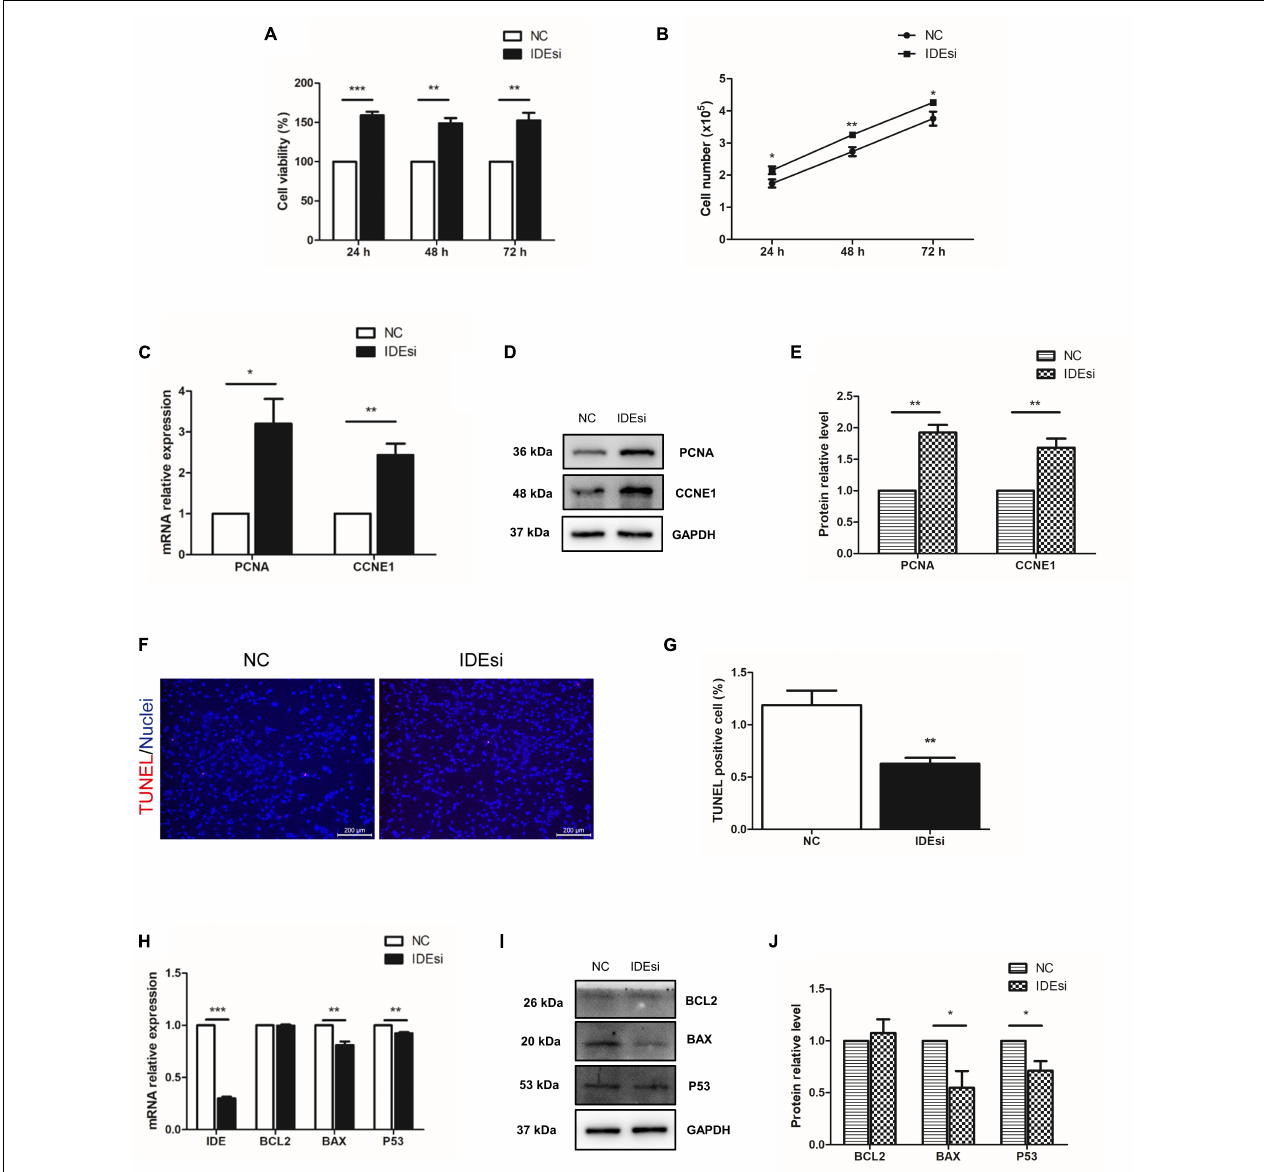
FIGURE 2 | Downregulation of IDE promotes the proliferation and mitigates the apoptosis of porcine skeletal muscle stem cells (PSMSCs). (A) CCK-8 assay shows that cell viability is increased in IDEsi group than that in NC group after transfection into PSMSCs for 24, 48, and 72 h. (B) IDE knockdown increases cell number compared with NC group after transfection into the same number of PSMSCs for 24, 48, and 72 h. (C–E) mRNA relative expression (C) and protein levels (D,E) of PCNA and CCNE1 of PSMSCs are increased in IDEsi group than those in NC group via RT-qPCR assay and western blotting analysis, respectively. (F,G) TUNEL assay discovered that IDE knockdown exhibited less apoptotic cells than control group. (H) RT-qPCR assay shows that IDE knockdown decreases mRNA relative expression of IDE , BAX , and P53 , but has no significant effect on the expression of BCL2 mRNA. (I,J) The protein levels of BAX and P53 but not BCL2 of PSMSCs are declined in IDEsi group than those in NC group. * P < 0.05, ** P < 0.01, and *** P <